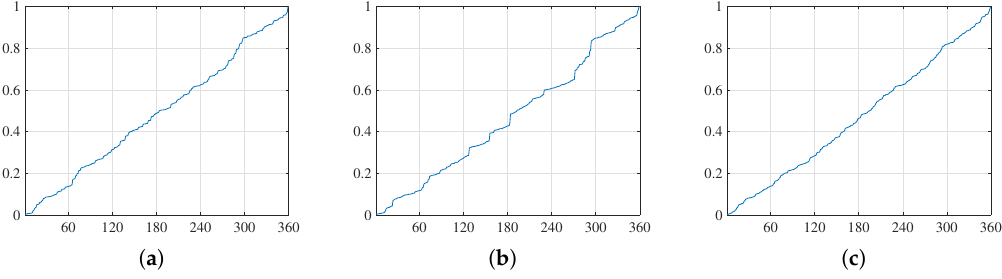
Figure 10. The normalized energy of received signal according to number of selected angles. ( a ) The pins; ( b ) the “ b ”-shaped metal pen inside a pencil case; and ( c ) cylindrical pencil vase with three metal